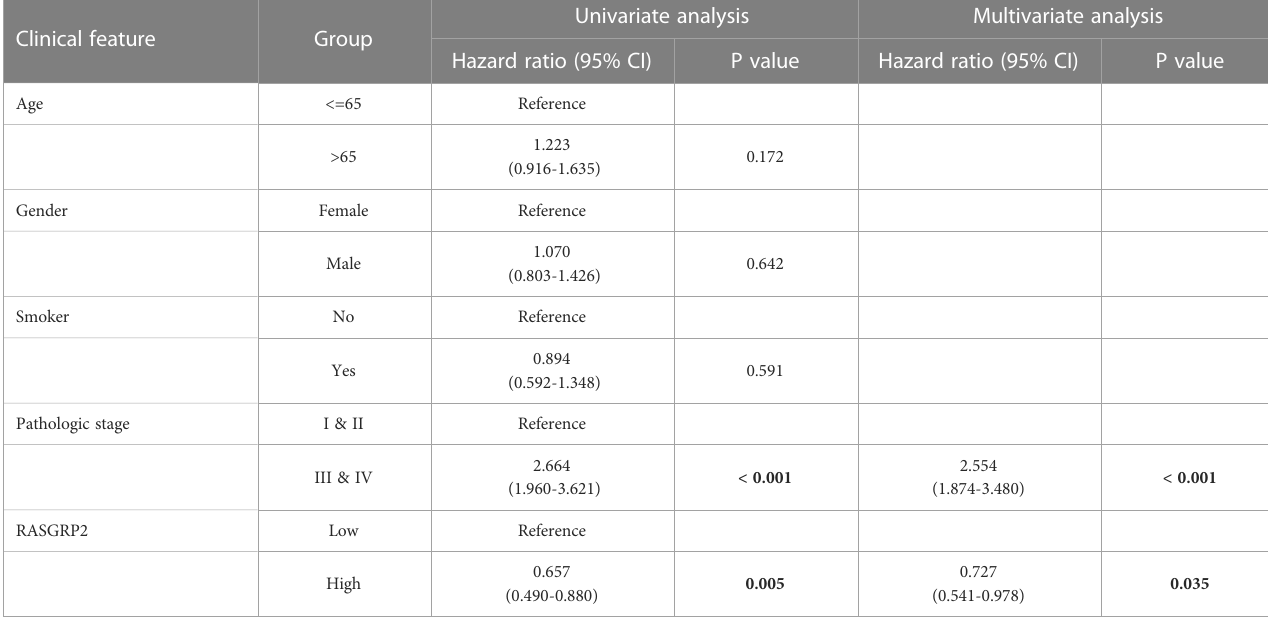
TABLE 1 Univariate and Multivariate Cox regression analysis of OS in TCGA-LUAD. Clinical feature Group